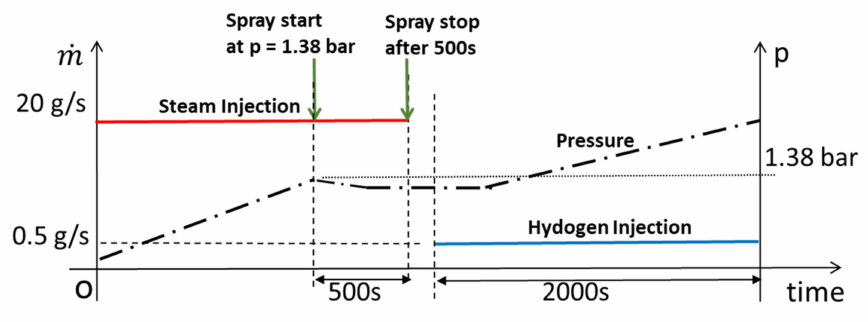
Figure 8. Schematic of the SSP3 test procedure.